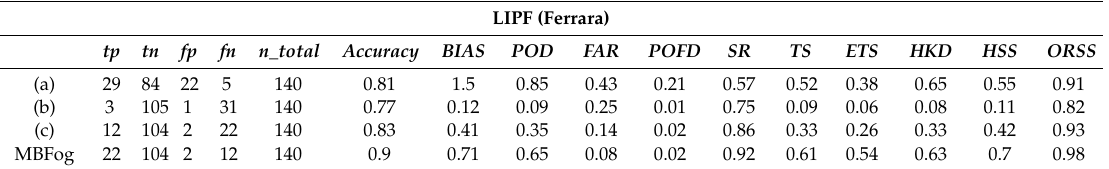
Table A7. Performances of several fog prediction methods for Ferrara site LIPF (Ferrara)